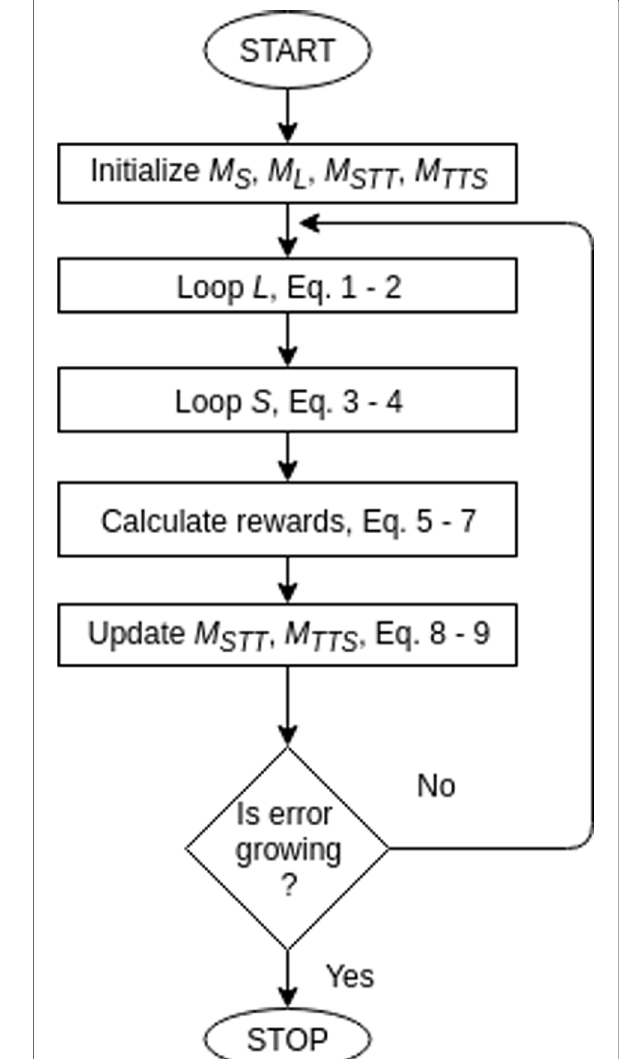
Fig. 3 DSL process for non-native speech